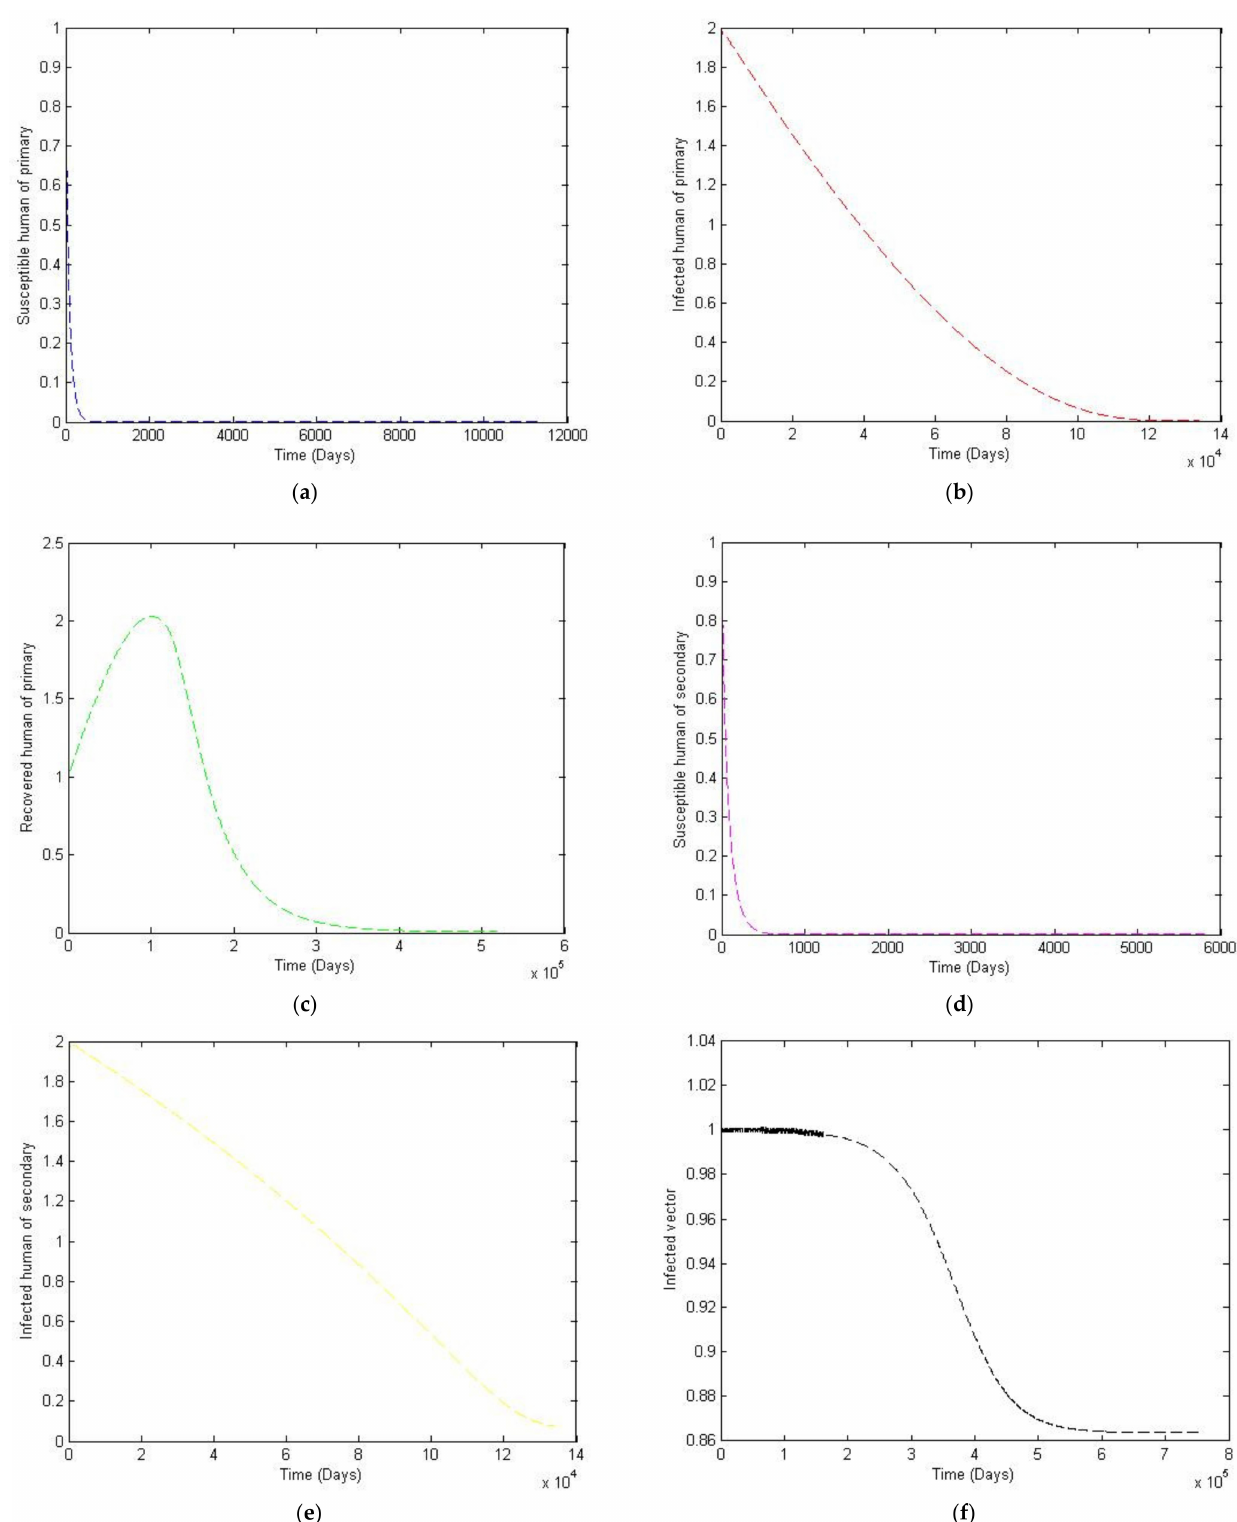
Figure 7. The trajectory of S HP , I HP , R HP , S HS , I HS and I V toward the endemic equilibrium point for R 0 > 1 with parameter values according to Table 3; changes N H = 500,000, and N V = 100,000 . ( a ) Susceptibles of primary infection ( b ) Infected population with primary infection ( c ) Recovered human of primary infection ( d ) Susceptibles of secondary infection ( e ) Infected human of secondary infection ( f ) Infected